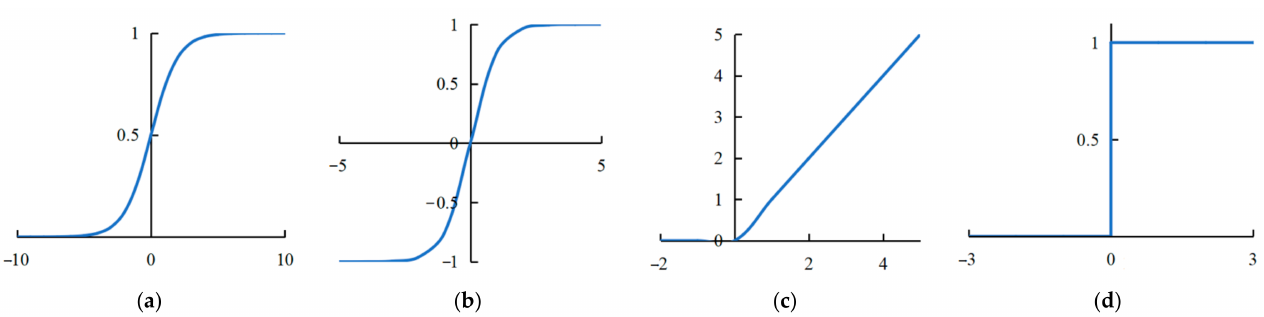
Figure 1. Four kinds of activation function curves: ( a ) Sigmoid, ( b ) Tanh, ( c ) ReLU, ( d ) ReLU after